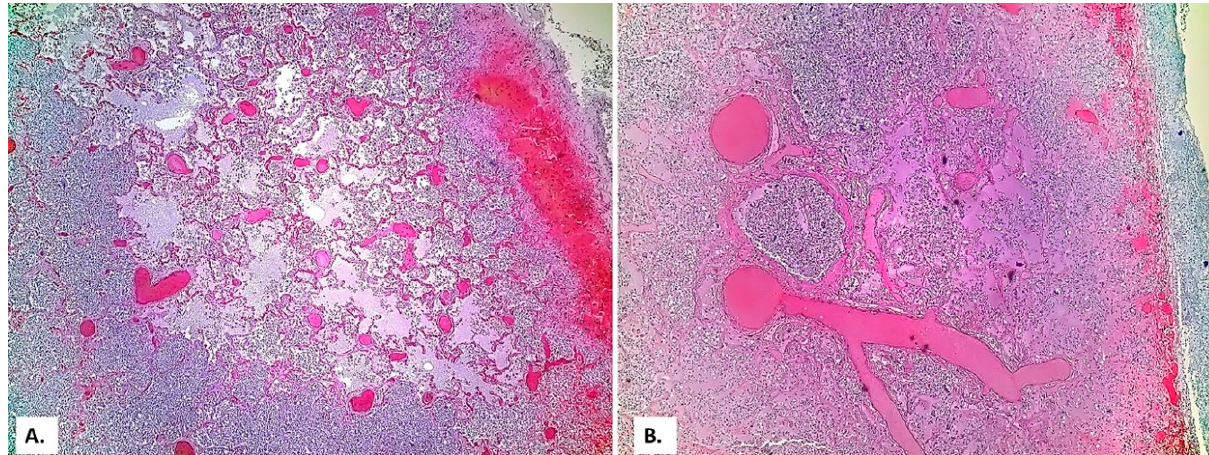
Figure 2. ( A ) General appearance of diffusely thickened alveolar septa (HE × 40). ( B ) Emphysema bubble surrounded by thick fibrous septa (HE × 100). ( C , D ) Thickened septa with myofibroblasts (HE × 200). In all images, the presence of abun- dant intra alveolar inflammatory exudate can be observed.